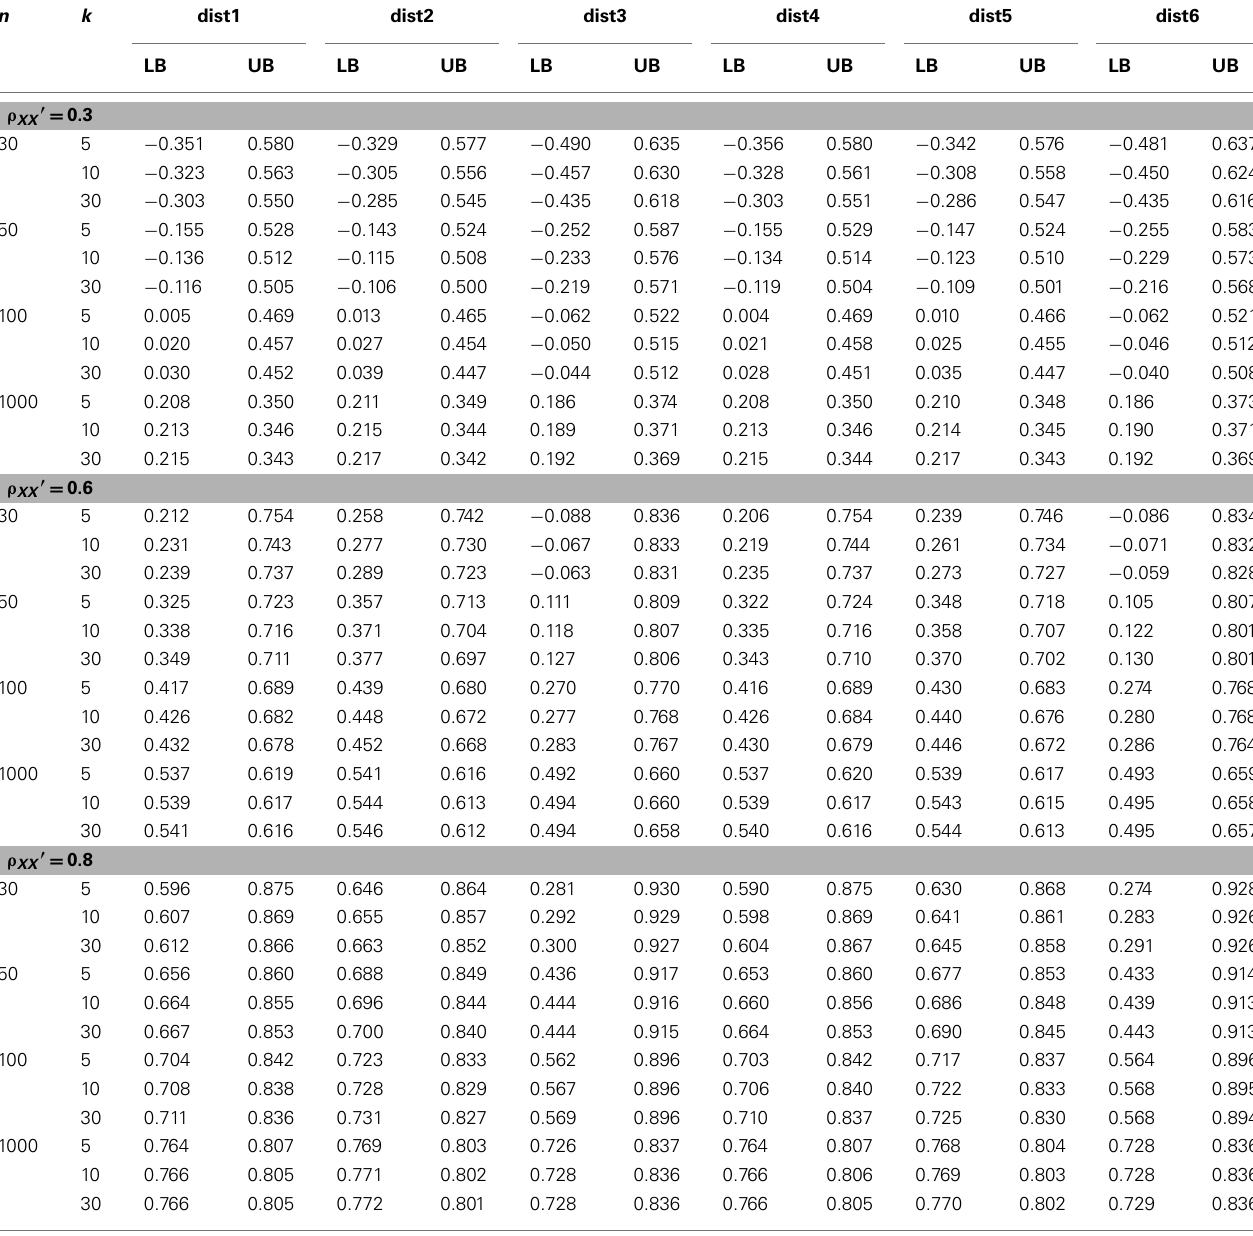
Table 3 | Observed 95% interval of the sample alpha ( ˆ α ) for the simulated situations where the true score ( t i ) distribution is normal or